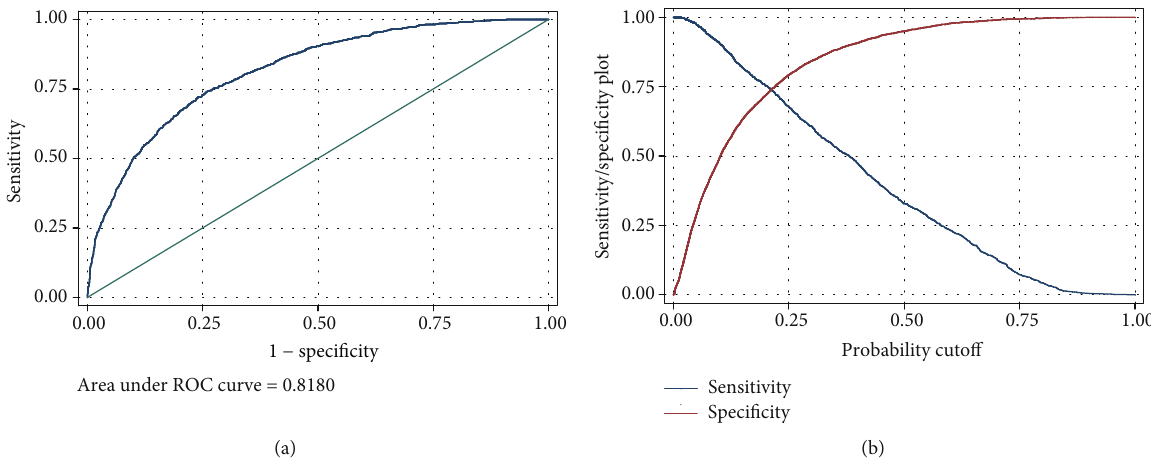
Figure 5: Performance of the logistic regression model (Table 3). The unit of the predictor is the result of the logistic function for each data as y = β 1 × 1 + β 2 × 2 + ⋯ + β 0 . (a) ROC curve. (b) Sensitivity/spesi fi city plot.